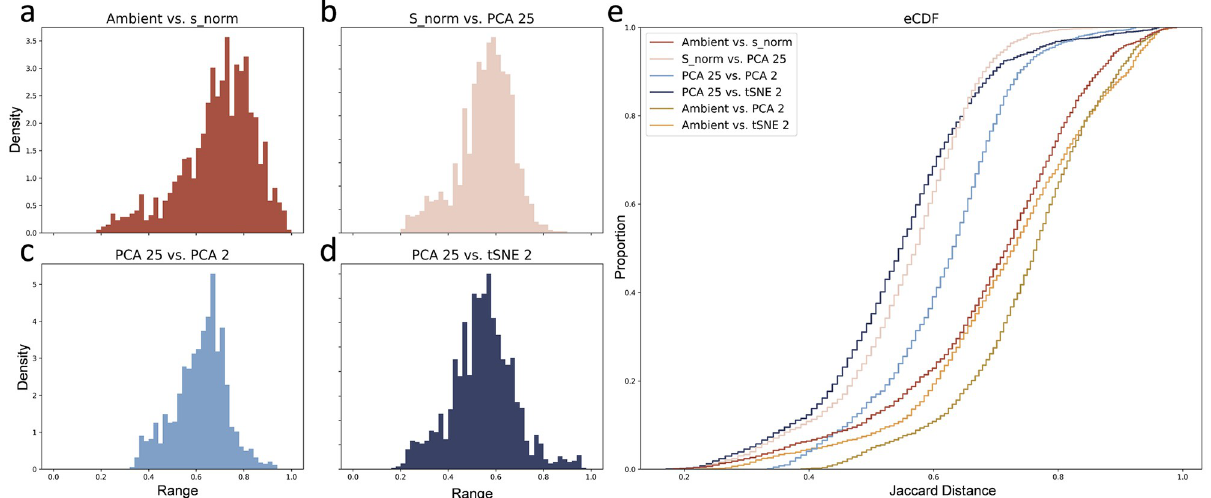
Fig 6. Normalization followed by two rounds of dimensionality reduction introduce distortions in the local neighborhoods. a. – d. Histograms of Jaccard distances between intermediate embeddings. e. Empirical cumulative distribution functions of Jaccard distances between intermediate embeddings, as well as the overall distortion (Ambient vs. PCA 2 and Ambient vs. tSNE 2). The palette used is derived from dutchmasters by EdwinTh.